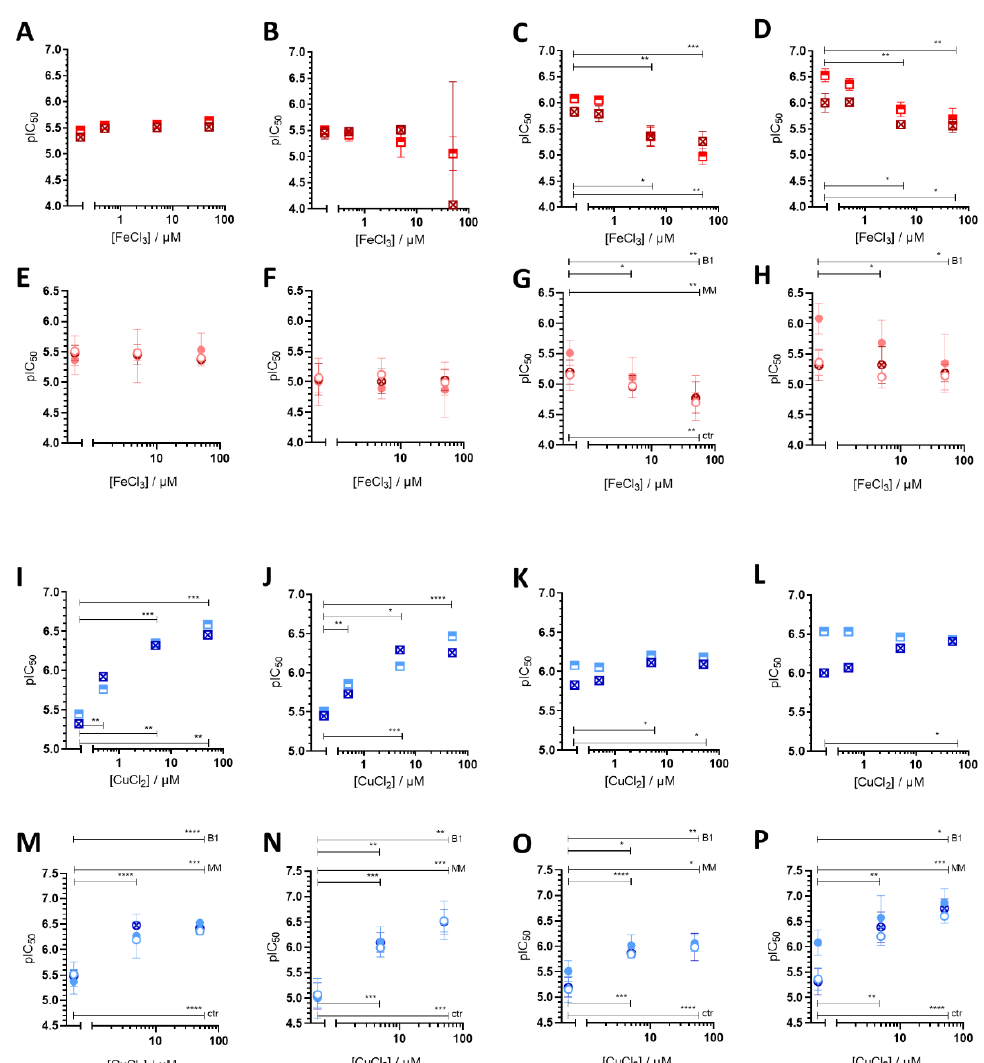
Figure 3. Involvement of Pgp in shaping cellular sensitivity to the ligands Q-1 ( A , E , I , M ), Q-2 ( B , F , J , N ), Q-3 ( C , G , K , O ) and Q-4 ( D , H , L , P ) in the presence of increasing concentrations of FeCl 3 (red, A – H ) or CuCl 2 (blue, I – P ). pIC 50 values of the ligands in the presence of FeCl 3 ( A – H ) and CuCl 2 ( I – P ) were obtained by MTT assay after 72 h incubation of Pgp expressing MES-SA/B1 cells in the absence (half-filled squares) and in the presence (crossed squares) of the Pgp inhibitor Tariquidar (TQ) ( A – D , I – L ). MDCK cells were used to further confirm the effect of Pgp (Panels E – H and M – P ). Wild type MDCK cells are displayed with open circles, cells transfected with Pgp (MDCK-B1) with filled circles and MDCK-MM cells transfected with a non-functional mutant MDCK-MM with crossed symbols. Data represent mean values and standard deviations obtained in at least three independent experiments (*: p ≤ 0.05, **: p ≤ 0.01, ***: p ≤ 0.001, ****: p ≤ 0.0001).